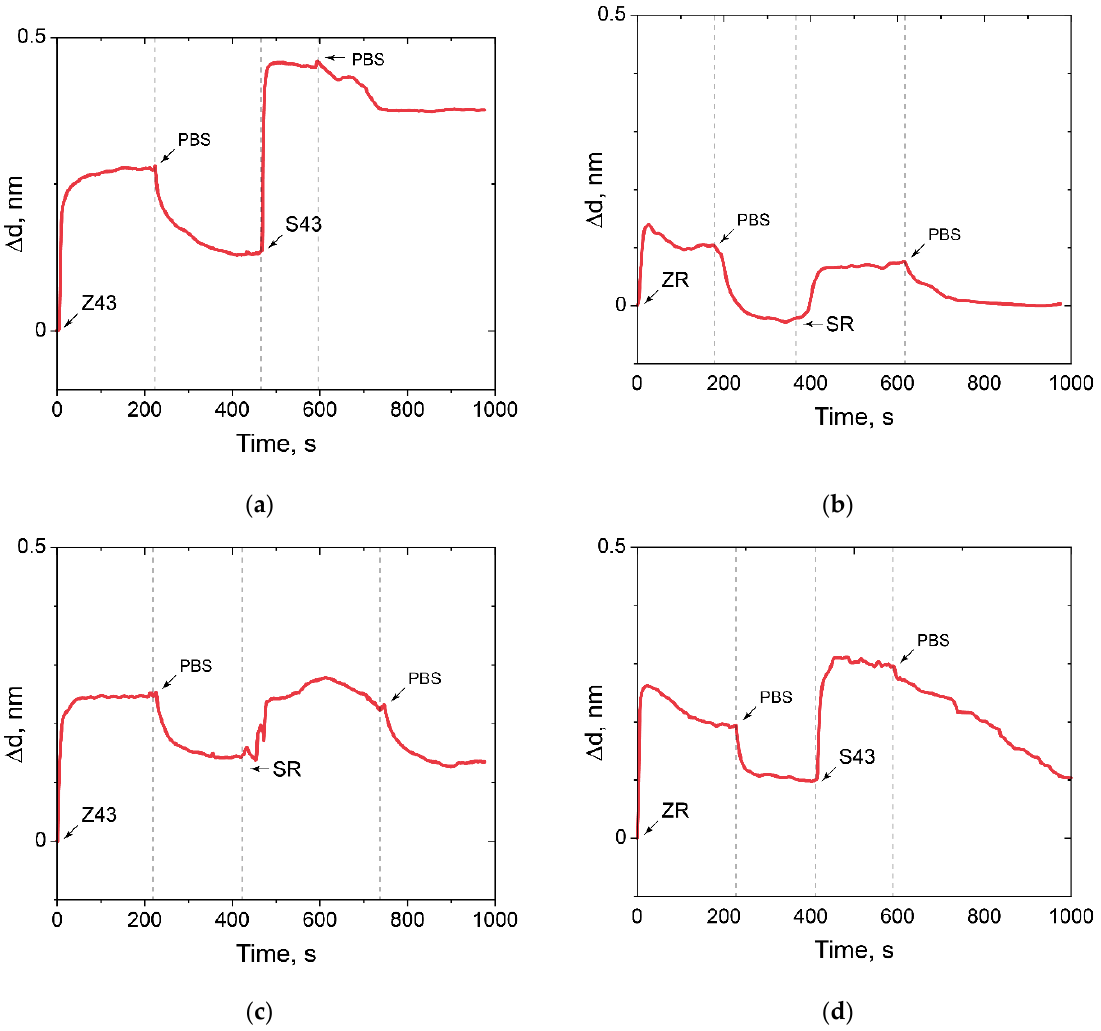
Table 2. Adlayer thickness ( ∆ d) upon the binding of the STP–biotinylated oligosensor with specific oligotargets: the PC surface modified with PAA and GA, APTES, and ED, and detection capacity increasing of the target low molecular weight molecules–oligonucleotide ED-modified PC surface in comparison with the control surfaces modified with APTES, PAA, and GA. ∆ d ED , ( ∆ d ED − ∆ d PAA − GA )/ ( ∆ d ED − ∆ d APTES )/ ∆ d PAA − GA , nm ∆ d APTES , nm ∆ d PAA-GA , % ∆ d APTES , % nm 0.31 63 0.14 121 63 The absence of binding of a random oligosensor and random oligotarget, random oligosensor and specific oligotarget, specific oligosensor and random oligotarget was demonstrated (Figure 10). In addition, it can be concluded that there is no nonspecific binding of any oligotarget to the modified PC surface.